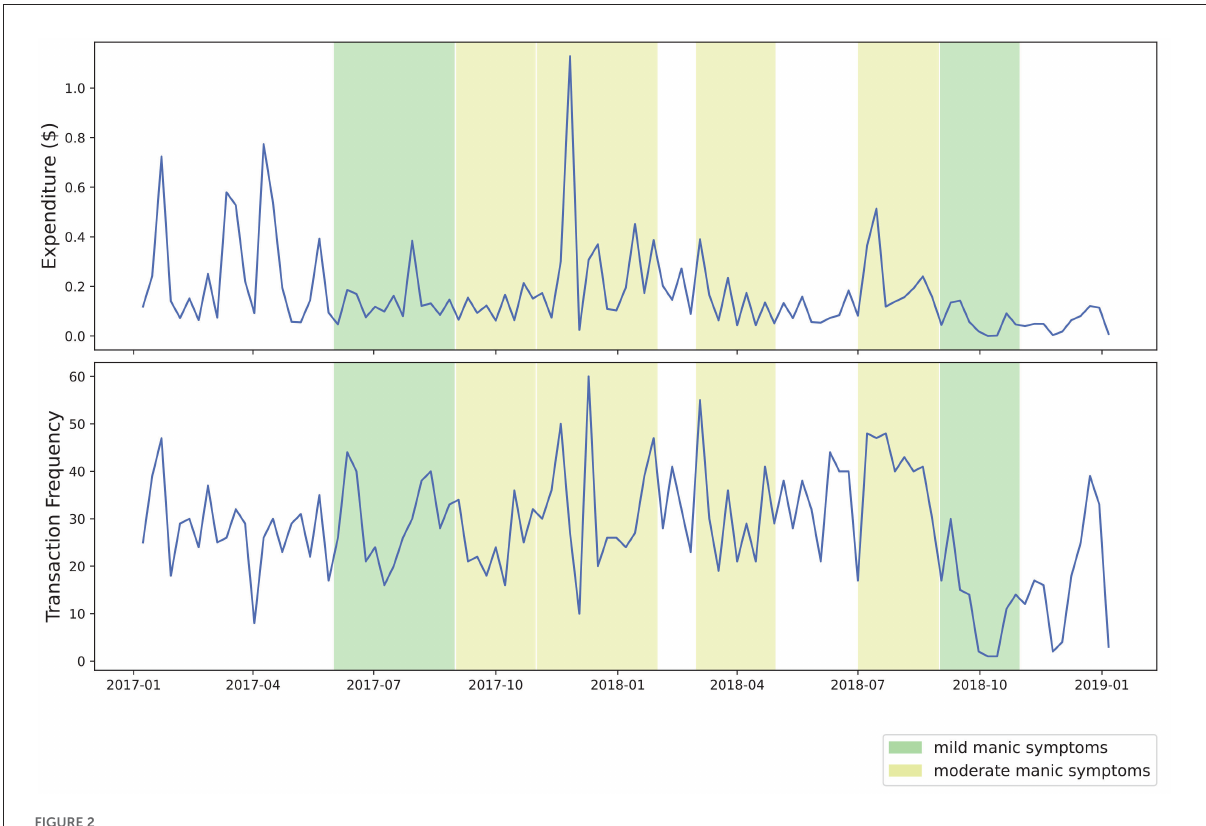
FIGURE2 Weekly expenditure from transaction